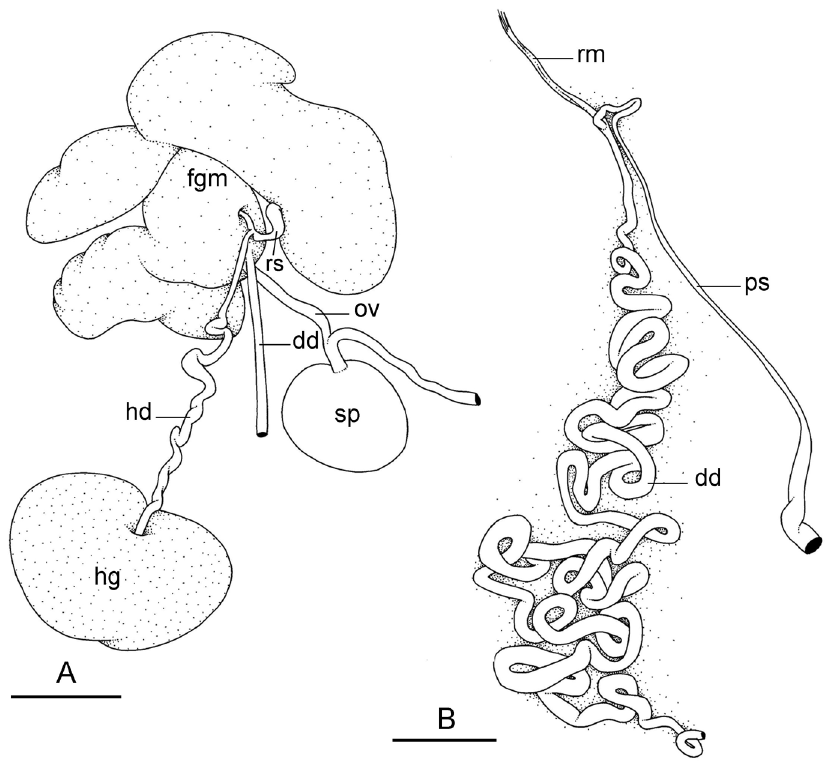
Figure 57. Reproductive system, Wallaconchis comendadori . A Hermaphroditic (female), posterior parts, Indonesia, Lombok, scale bar 3 mm [2985] (UMIZ 00063) B Anterior, copulatory parts, Philippines, Bohol, scale bar 2 mm [3385] (PNM 041234). Abbreviations: dd deferent duct fgm female gland mass hd hermaphroditic duct hg hermaphroditic gland ov oviduct ps penial sheath rm retractor muscle rs receptaculum seminis sp spermatheca.